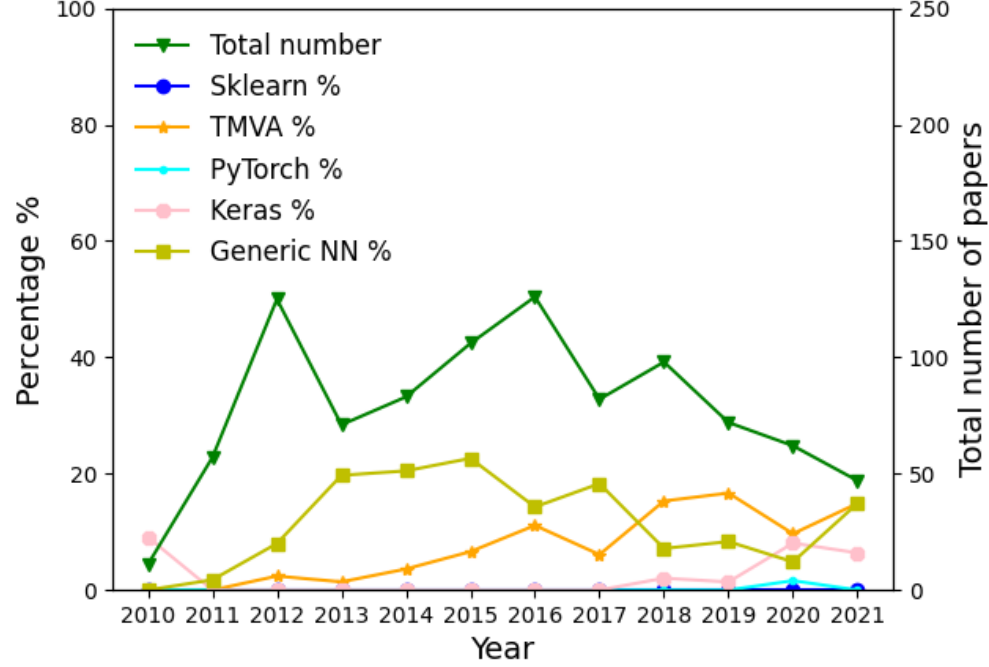
Figure 2. Usage of ML at ATLAS across the years. We show the number of papers published every year (denoted as “Total number” and corresponding to the right axis), as well as the fraction of them reporting the use of TMVA, Sklearn, Keras, PyTorch and Generic NNs (in the left axis). The latter category corresponds to papers mentioning the use of NNs but never referencing any of the aforementioned